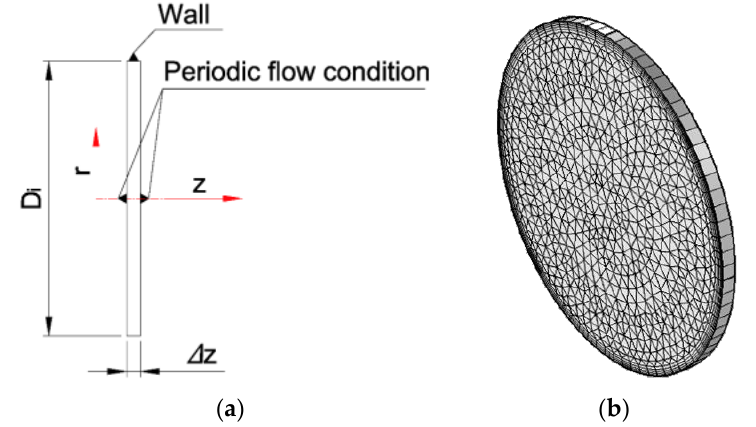
Figure 4. Verification at the tube section: ( a ) boundary condition, ( b ) grids system.